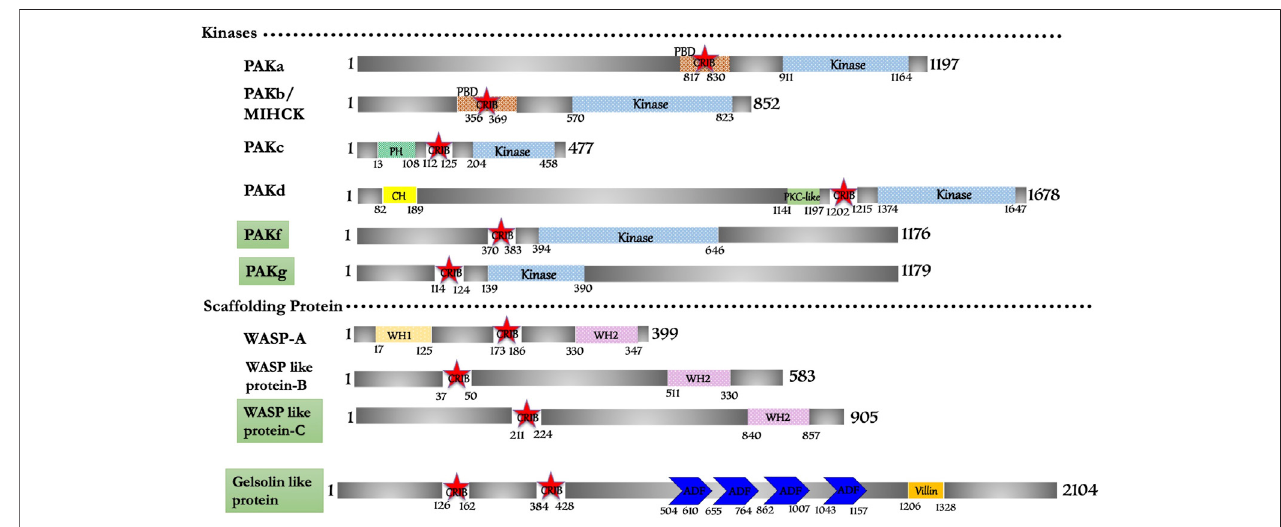
FIGURE 2 | Schematic diagram of domain organization of Dictyostelium discoideum , CRIB domain containing proteins. The domain names and amino acid is labeled. The abbreviations for the domains are: CRIB, Cdc42/Rac interactive binding; CH, Calponin Homology; PBD, p21-activated binding domain; PH, pleckstrin- homology;WH1,Enabled/VASP homology 1;WH2, WASPhomology 2;ADF,Actin depolymerizing factor. Theproteins already knownfromtheearlierliterature,but not characterized yet are marked as green colored box. The proteins marked in orange (subtle effect) boxes are reported for the fi rst time in this in silico study and are completely uncharacterized. Footnote: In Dictyostelium discoideum , PAKa-d can be studied for their protein structure and interaction studies with respective Rac repertoire or Cdc42. The functional role of PAKa-d in cell motility, adhesion, phagocytosis and chemotaxis represent their crucial role in unicellular protozoans, and comparative studies in parasite protozoans would be the scope of future